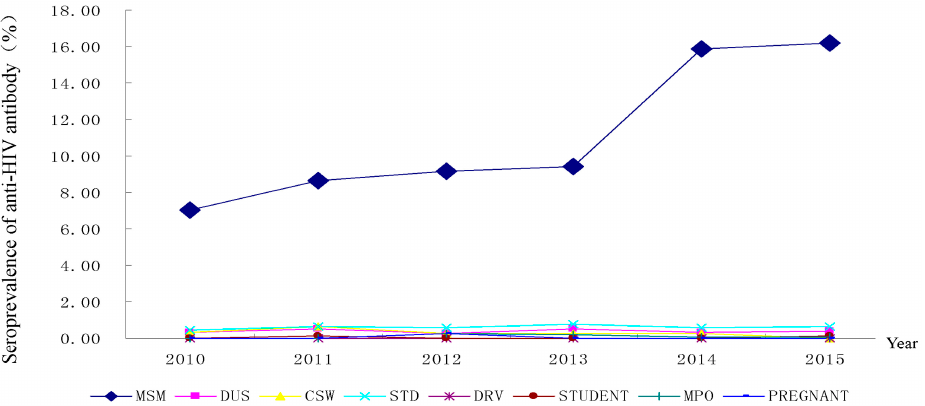
Figure 9. Seroprevalence of anti-HIV antibody in sentinel sites of Fujian Province from 2010 to 2015. MSM, men who have sex with men; DUS, drug users; CSW, commercial sex workers; STD, male patients attending STD clinics; DRV, long-distance male bus drivers; STUDENT, young students; MPO, mobile population; PREGNANT, pregnant women.